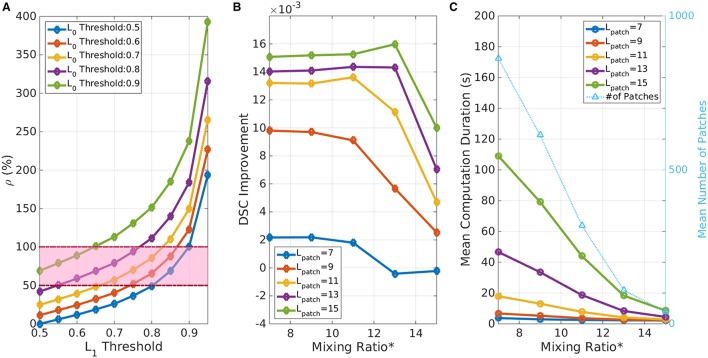
Parameter selection. (A) Effect of confidence threshold values on image partitioning. ρ represents the ratio of low-confidence voxels over high-confidence structural voxels. The highlighted region denotes the heuristically “good” region for threshold selection. (B) Effect of mixing ratio and Lpatch on DSC performance. Mixing Ratio* is the minimum required number of SH nodes in the 26-node neighborhood for a given seed voxel. Note that with a larger Lpatch performance improves. Whereas, with a smaller Lpatch or a higher mixing ratio* the performance worsens due to poor coverage over SL region. (C) Effect of mixing ratio and Lpatch on computational cost. The light blue line shows the number of patches for given configuration as a reference. Note that the computation time increases exponentially with a higher Lpatch and a smaller mixing ratio* (Note: mixing ratio* represents the equivalent number of minimum SH node requirement in the 26-node neighborhood for the seed node selections).